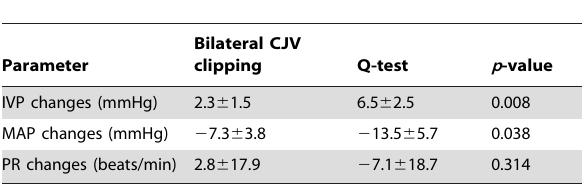
Table 3. Comparison of changes in the intraventricular pressure, mean arterial pressure, and pulse rate between Queckenstedt’s test and bilateral common jugular venous